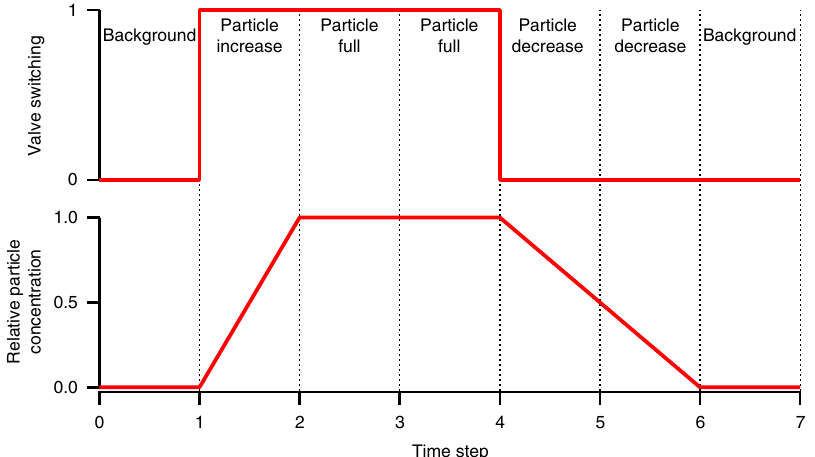
Fig. 2 The seven-step procedure of the differential background subtraction method. The upper graph shows the switching cycle between pure gas (zero in the diagram) and particle-laden gas (one in the diagram) of the switching module. The lower diagram displays the theoretically expected relative particle concentration in the fl ow tube. Since it takes longer to diminish the particle concentration in the fl ow tube by fl ushing with pure gas, the decrease phase was scheduled with two time steps. The different phases are marked in the upper section. The time steps with full particle concentration are reserved for the actual SAXS measurements